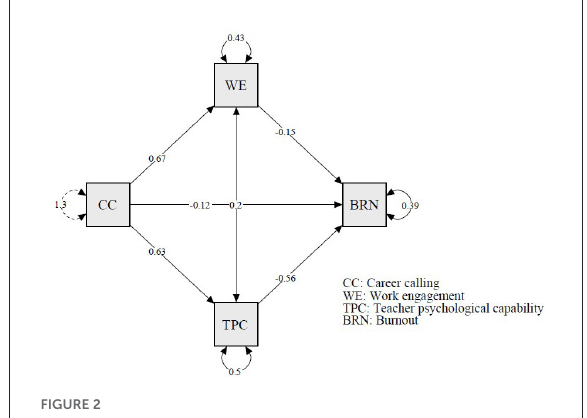
FIGURE2 The results of sequential mediation